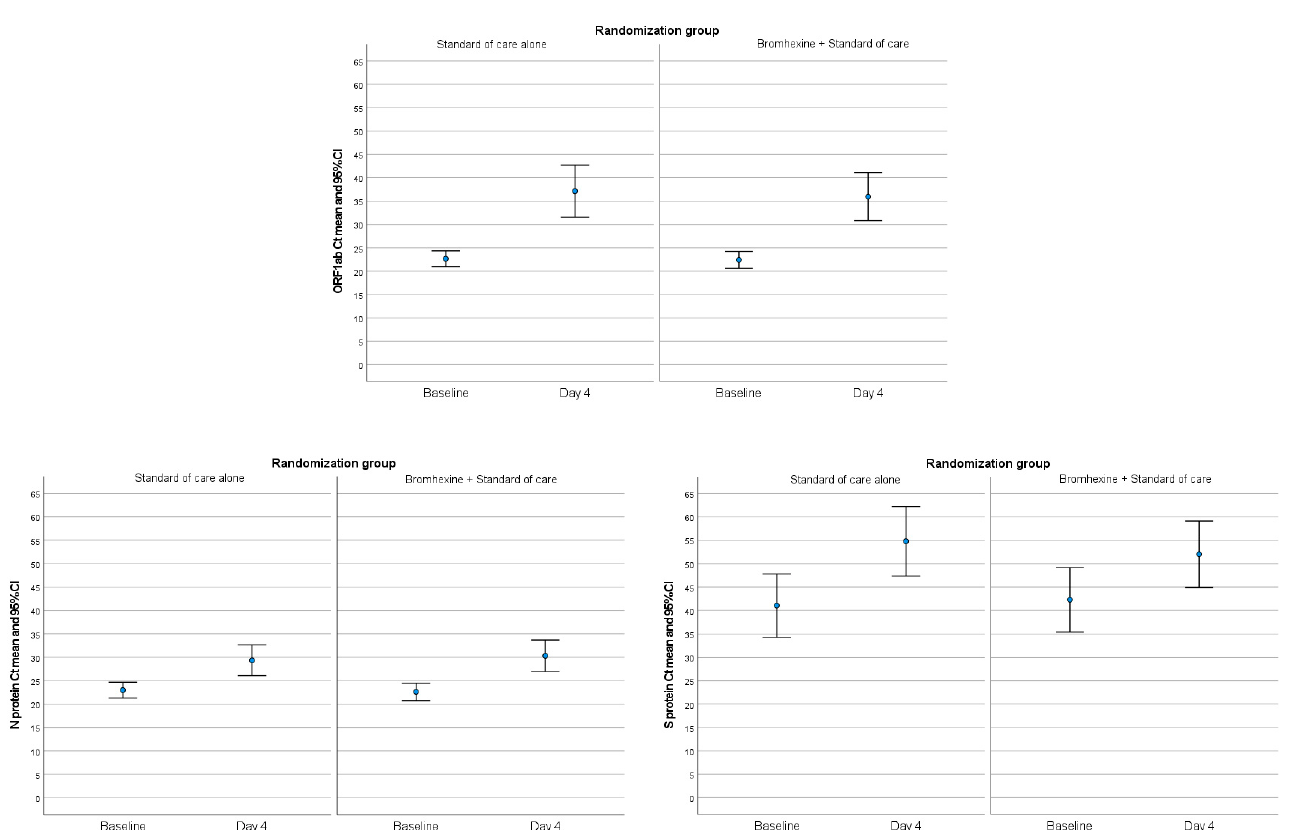
Figure 2. Reduction of viral load from baseline to day 4 of treatment for ORF1ab, N Protein, and S Protein in the two study groups. For all the comparisons Baseline versus Day 4, p value was < 0.001. In the overall study population, Ct values of ORF1ab, N Protein, and S Protein in- creased significantly from baseline throughout days 4 to 14 ( p < 0.001). For the comparison of Ct values of ORF1ab between the two study groups, there were no significant differ- ences on day 4 ( p = 0.765), day 7 ( p = 0.431), and day 14 ( p = 0.163). Similar findings were obtained for Ct values of N Protein at day 4 ( p = 0.678), day 7 ( p = 0.961), and day 14 ( p = 0.583), as well as for Ct values of S Protein at day 4 ( p = 0.592), day 7 ( p = 0.450), and day 14 ( p = 0.124) (Figure 3).